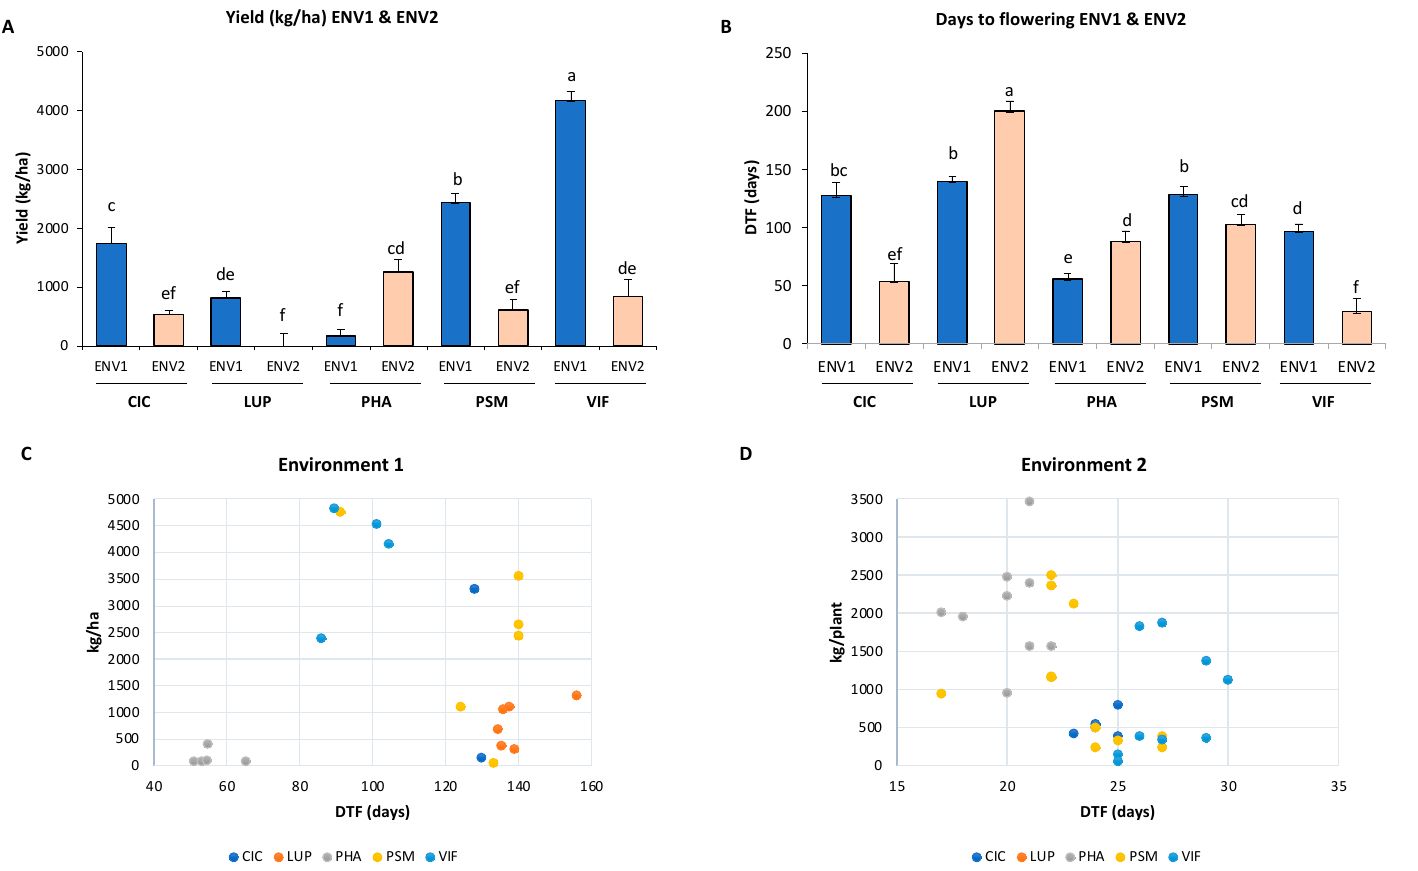
Figure 3. Mean comparison and standard error for ( A ) seed yield and ( B ) days to flowering among the genotypes of the five grain legume species in ENV1 and ENV2. Scatter plot matrix ranking of the genotypes of the five grain legume species for days to flowering (DTF) versus seed yield (kg ha − 1 ) in ( C ) ENV1 and ( D ) ENV2. Data for the latest flowering genotypes (DTF = >120) or no flowering (DTF = 200) in Environment 2 were removed in order to more clearly show the dispersion. Different letters indicate significant differences between means among the genotypes of the five grain legume species and environments, ENV1 and ENV2, at p < 0.05 by Tukey’s HSD test. Each bar represents mean + SE (standard error). Significant differences among species, and significant interactions between species by environment, were recorded at p < 0.05. VIF ( Vicia faba ), PSM ( Pisum sativum ), CIC ( Cicer arietinum ), PHA ( Phaseolus vulgaris ), and LUP ( Lupinus spp .).